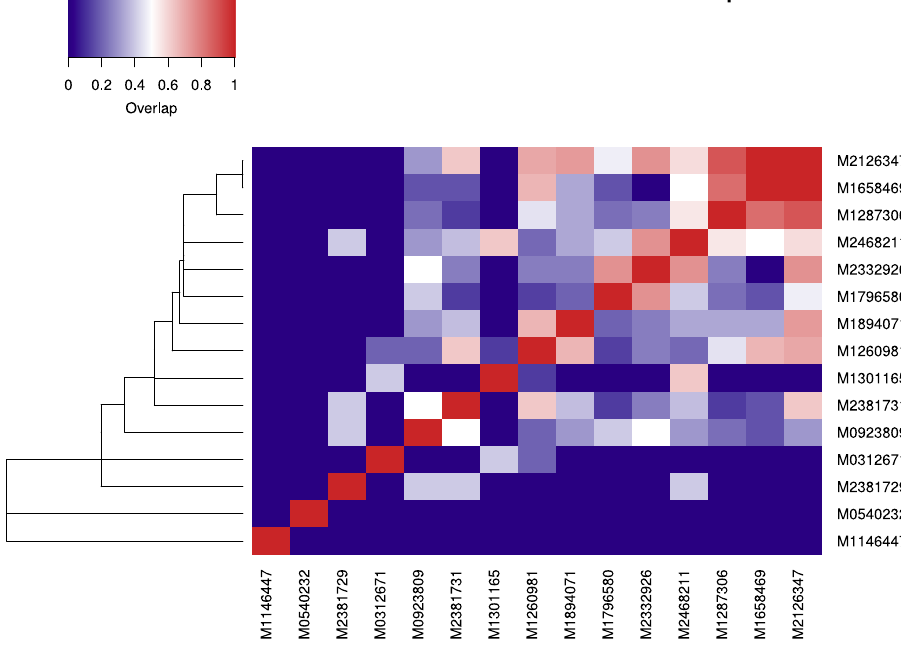
Figure 3. Overlap between predicted instances of reoccurring RNA structure motifs. The overlap between the predicted instances is depicted for 15 CRS motifs. The 15 CRSs are well conserved and predicted inside enriched structured regulatory elements for at least three different differentially expressed genes. The overlap between instances a CRS motif A and instances of a CRS motif B is computed by = ∩ | | shows a single-linkage hierarchical clustering between the CRS